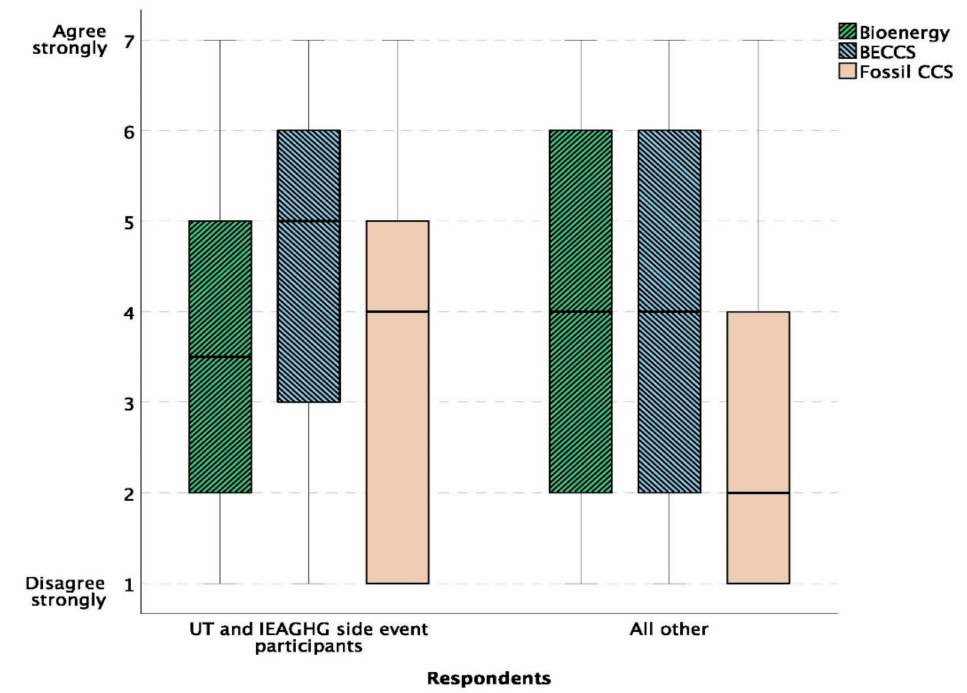
Figure 4. Views of the importance of bioenergy, BECCS and fossil CCS from participants who were surveyed within the UNFCCC side-event on CCS versus those who were sampled within the general delegate population. Side-event data are from COP 22, 24, and